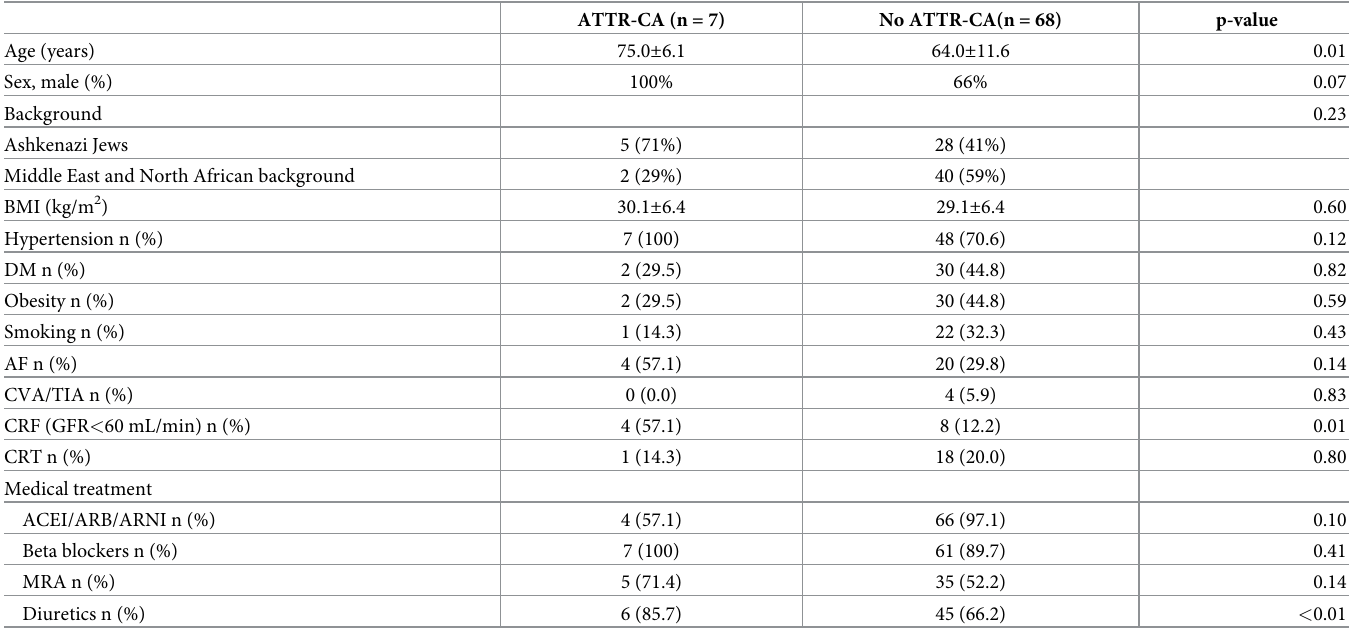
Table 1. Baseline characteristics of patients with and without